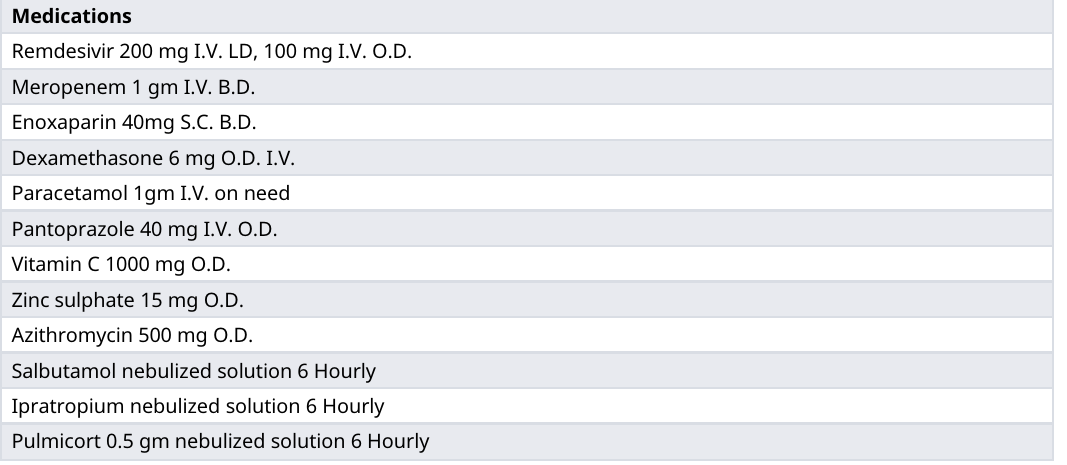
Table 1. COVID-19 treatment medications administered to the patients. Medications